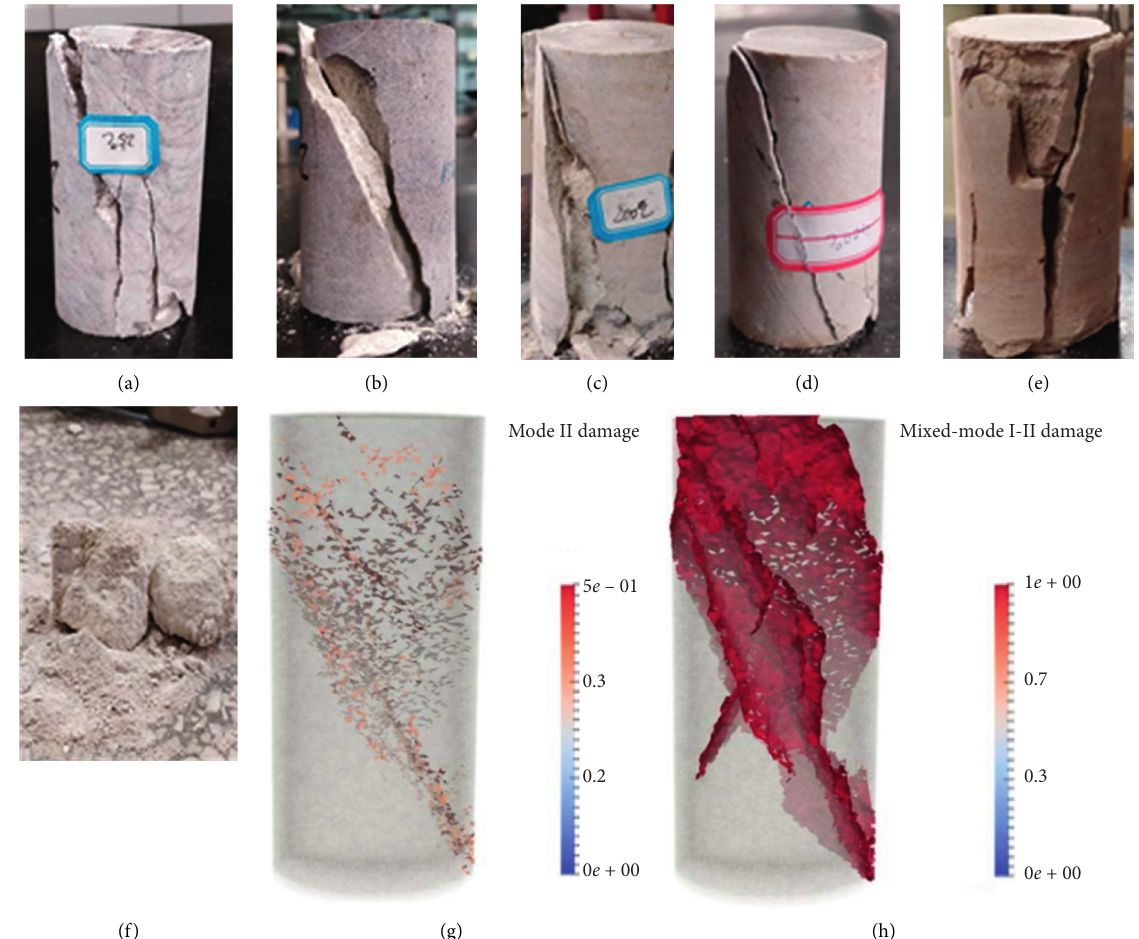
Figure 7: Fracture patterns for the UCS test under different temperatures: (a–f) experimental results; (g) mode II damage [55]; and (h) mixed-mode I-II damage [55]. (a) 25 ° C. (b) 100 ° C. (c) 200 ° C. (d) 400 ° C. (e) 600 ° C. (f) 800 ° C.